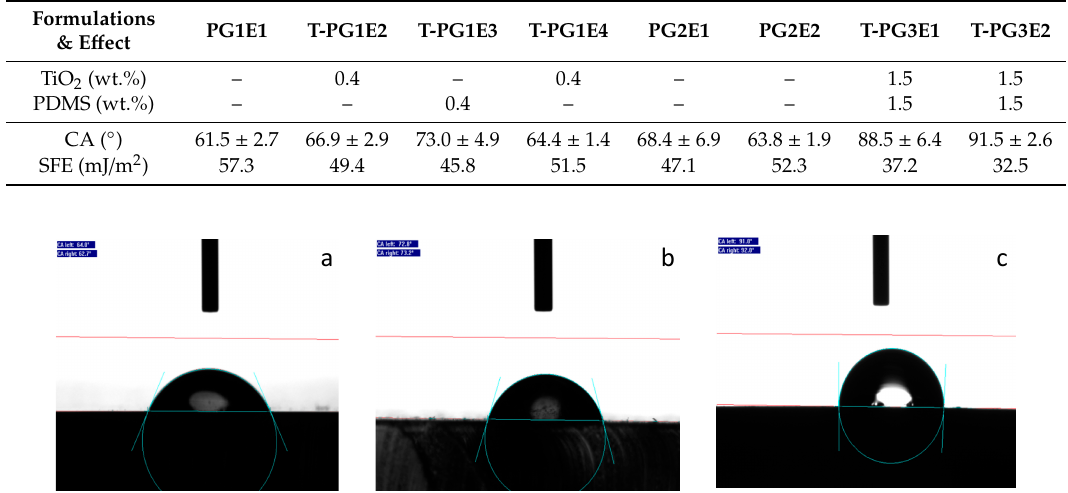
Figure 4. Surface contact angle (CA) of coating surface ( a ) contact angle of PG2E2 (0.0 wt.%TiO 2 ) 63.8° ± 1.9°, ( b ) contact angle of T-PG1E2 (0.4 wt.%TiO 2 ) 66.9° ± 2.9°, and ( c ) contact angle of T-PG3E2 (1.5 wt.%TiO 2 ) 91.5° ± 2.6°.